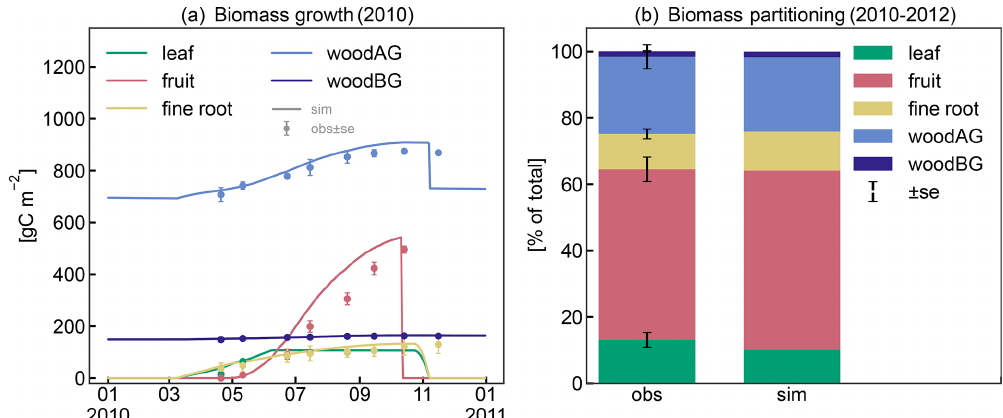
Figure 4. (a) Observed and simulated growth of leaves, fruits, fine roots, and aboveground (live and dead stem) and belowground (live and dead coarse roots) biomass during 2010. (b) Observed and simulated biomass components between 2010 and 2012 as percentage of total biomass.